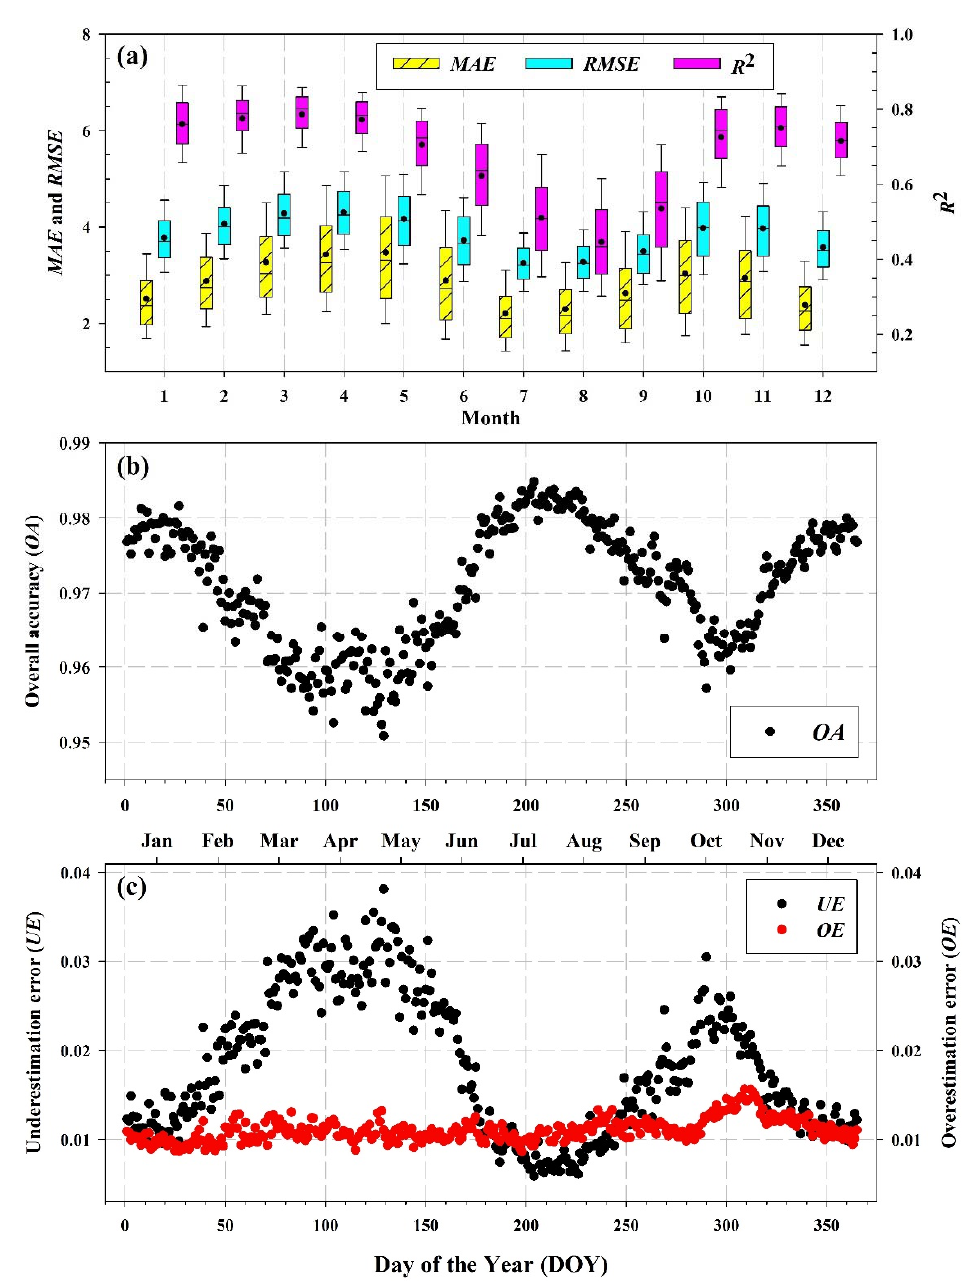
Figure 13. Performance metrics for NDSI and classification accuracy of the TAC filter. ( a ) Box plot of MAE (yellow), RMSE (blue), and R 2 (pink) for the TAC algorithm. The top and bottom of each box are the 75th and 25th percentiles, respectively. The whiskers show the 5th (bottom) and 95th (top) percentiles. The horizontal line inside each box represents the median, while the dot inside each box is the mean. ( b ) Scatterplot of the overall accuracy ( OA ) for the TAC algorithm. ( c ) Scatterplot of the underestimation error ( UE , black dot) and overestimation error ( OE , red dot) for the TAC algorithm.